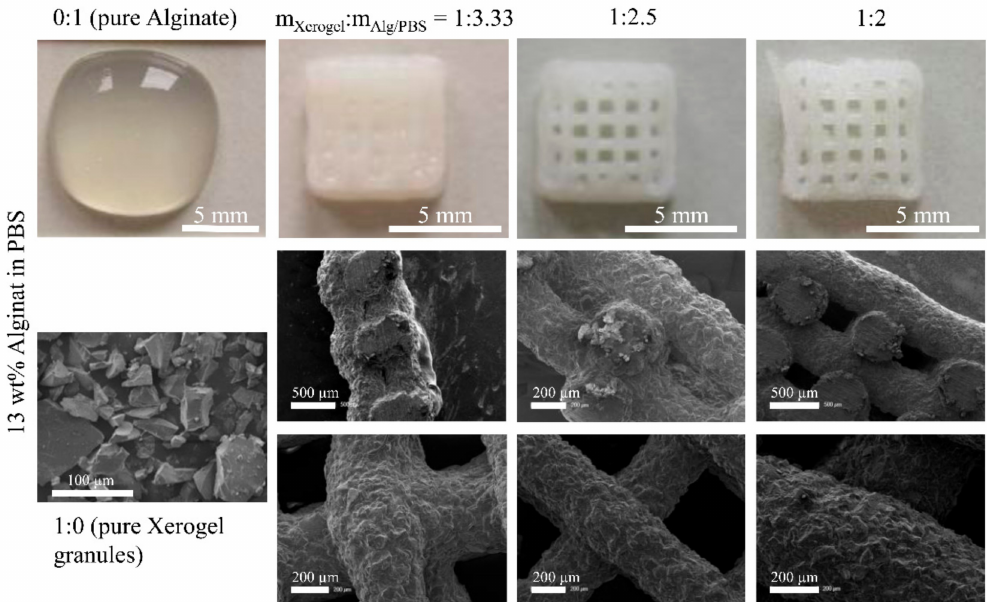
Figure 5. Photographs of 3D plotted biomaterial inks (upper row). Pure alginate (0:1) with 13 wt.% in PBS without dimensional stability after 3D plotting and plotted composite scaffolds with Xerogel/Alg mass ratios of 1:3.33, 1:2.5, and 1:2. SEM images (lower rows) of pure Xerogel granules (<125 µ m in size), as well as 3D plotted Xerogel/Alg scaffolds. Cross-section (middle row) and surface (lower row) of scaffolds containing a matrix of 13 wt.% alginate in PBS and Xerogel granules with component ratios of 1:3.33, 1:2.5, and 1:2. Table 2. Measured strand diameter (mean and standard deviation) in the as-printed state, as well as in the dry state. In case, no single strands were present after printing, the strand diameter is not available (n.a.).